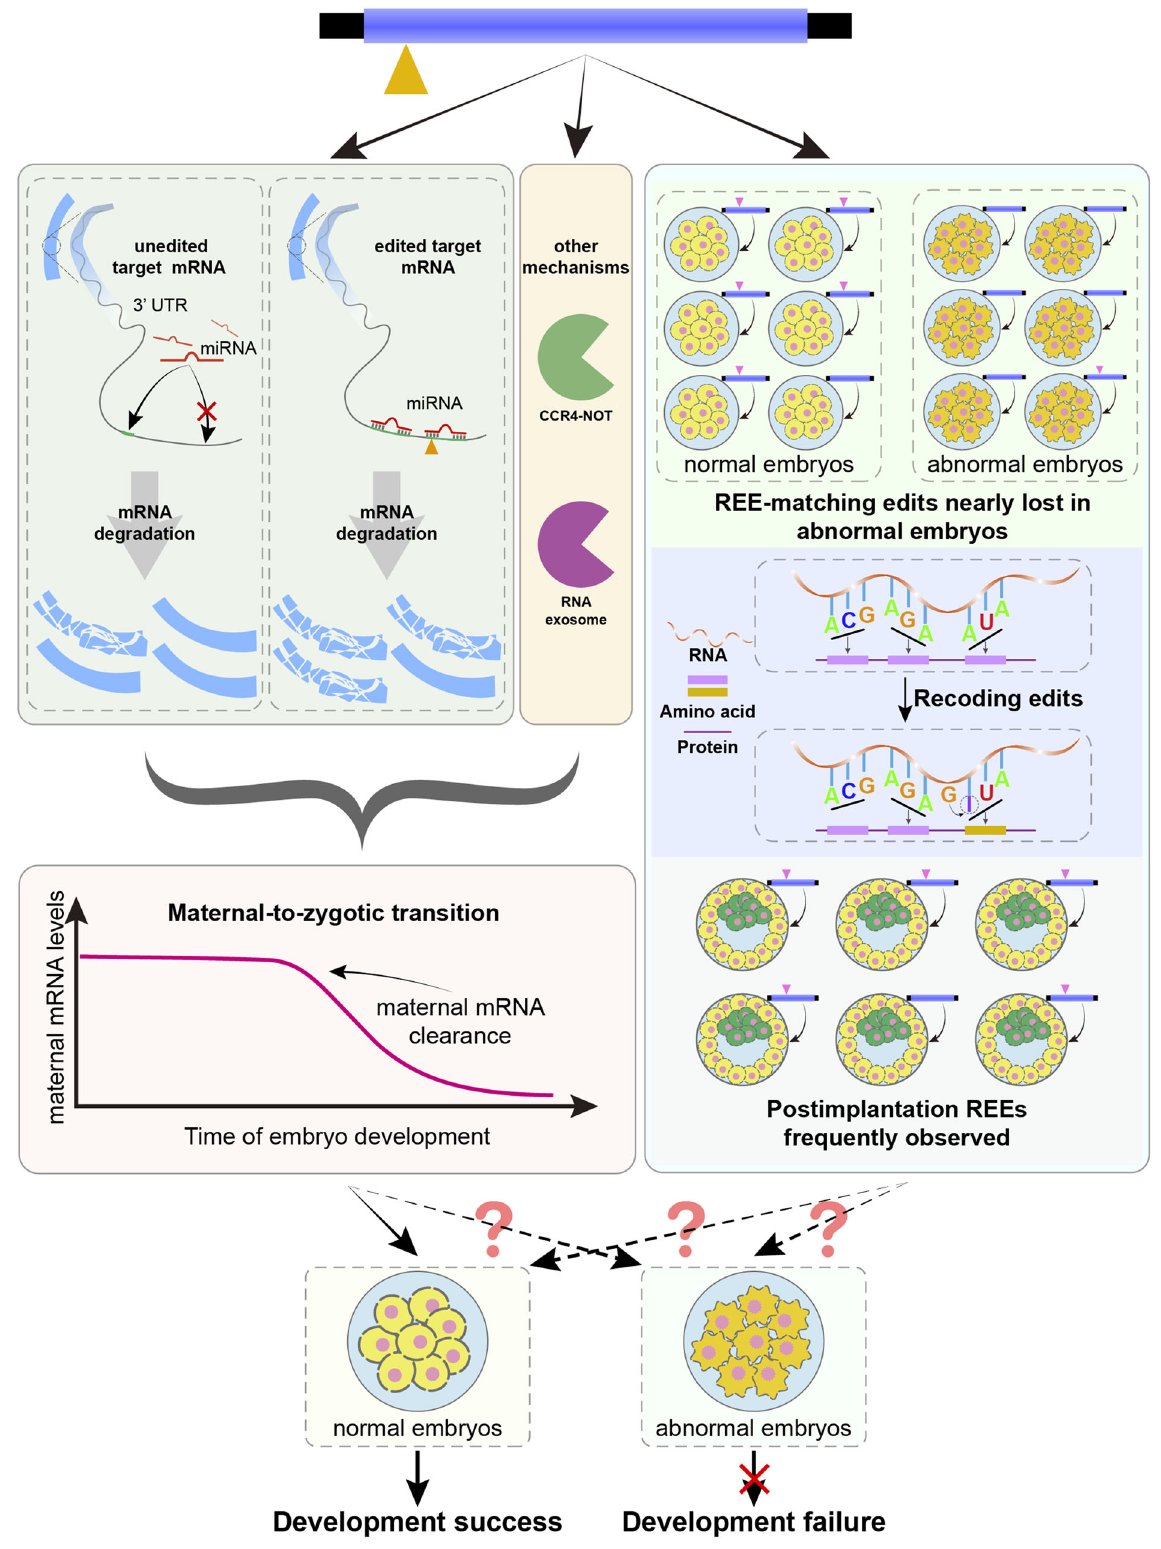
Fig. 6 Proposed model of how human embryos take advantage of REEs (and other